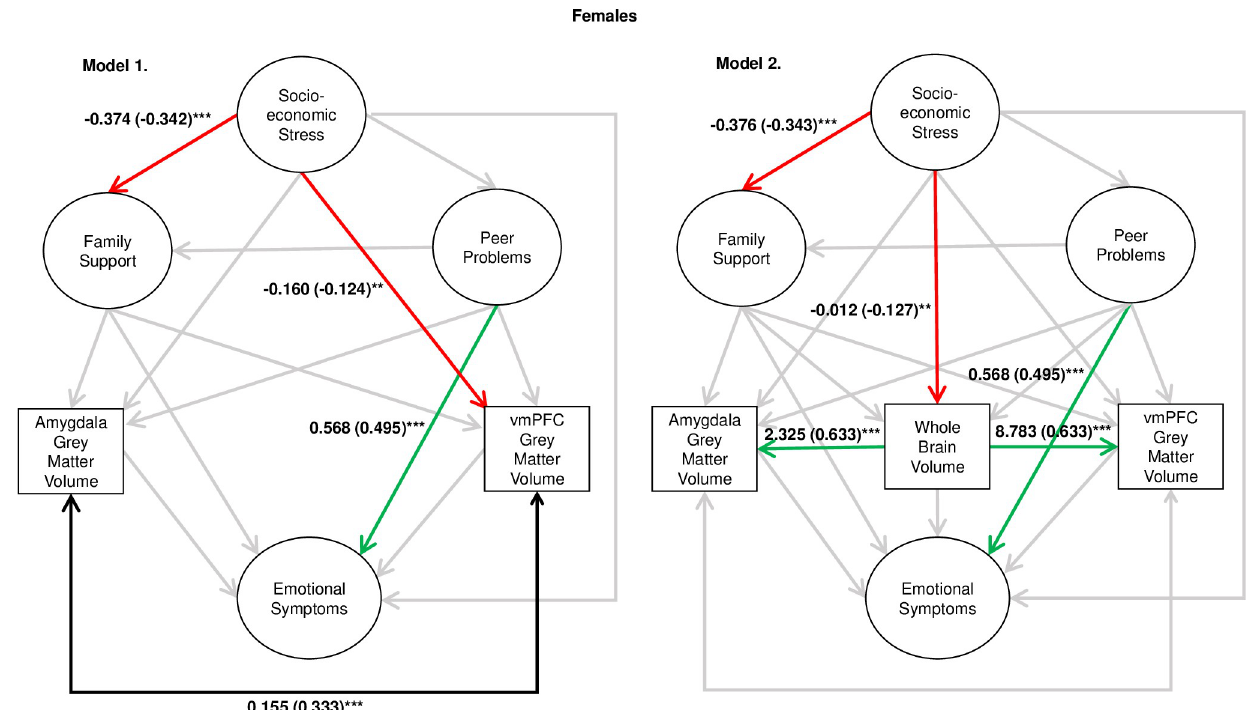
Fig 4. Results for models 1 and 2 for the female sample. Note. ��� = p < .001, �� = p < .01, � = p < .05. Estimates are unstandardised path coefficients (standardised in parentheses). Amygdala and vmPFC GMV values were divided by 1,000, and WBV was divided by 1,000,000, so that the values were closer in magnitude to other variables in the